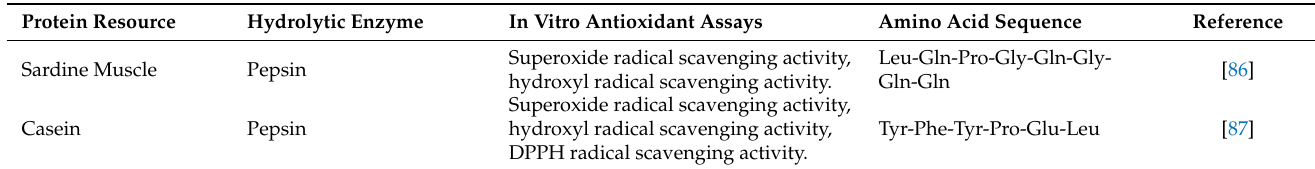
Table 3. Amino acid sequence of antioxidant